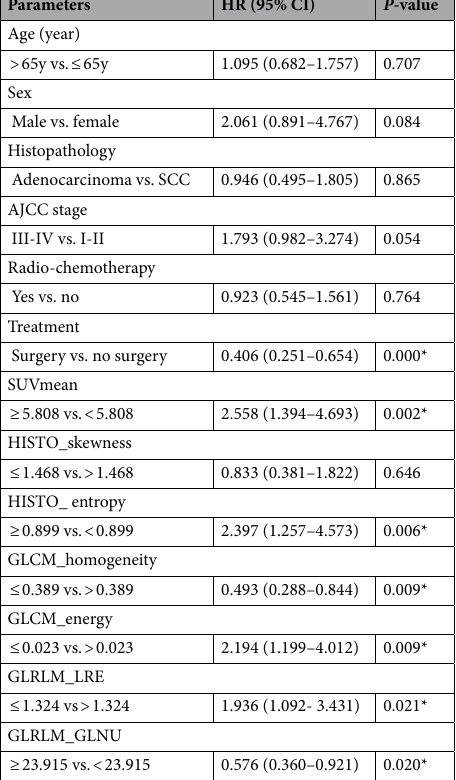
Table 4. Univariate analysis of both clinical and textural factors with OS. HR hazard ratio, CI confidence interval, AJCC American joint committee of cancer, SCC squamous cell carcinoma, SUV standardized uptake value, HISTO histogram, GLCM grey level co-occurrence matrix, GLRLM grey level run-length matrix, LRE long run emphasis, GLNU gray level non-uniformity for run. *Significant P -value (< 0.05).